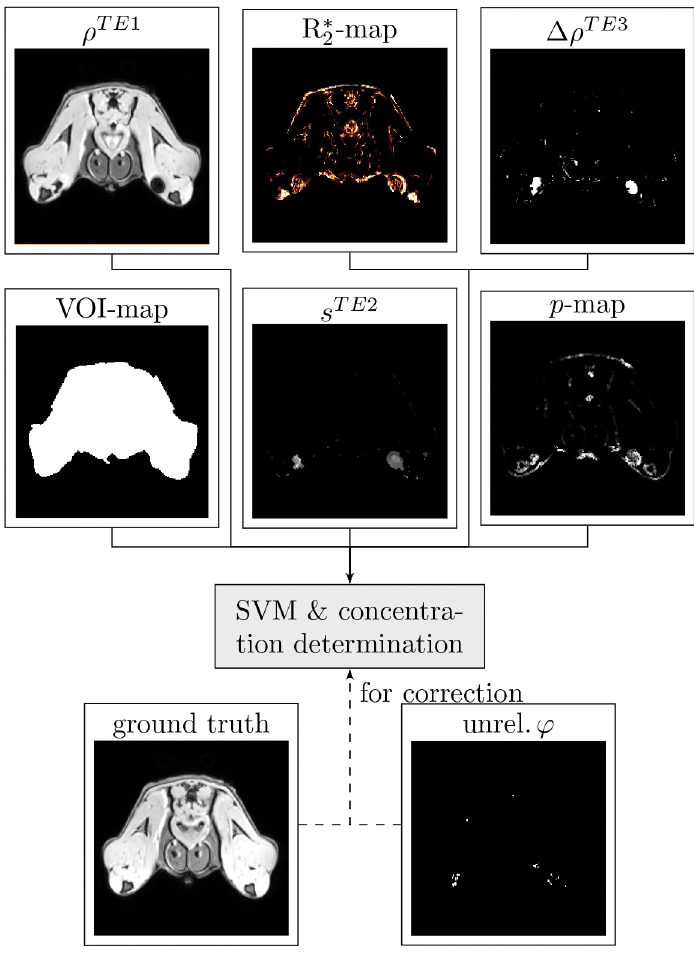
Fig 6. Overview of the features extracted from the image data of the in-vivo